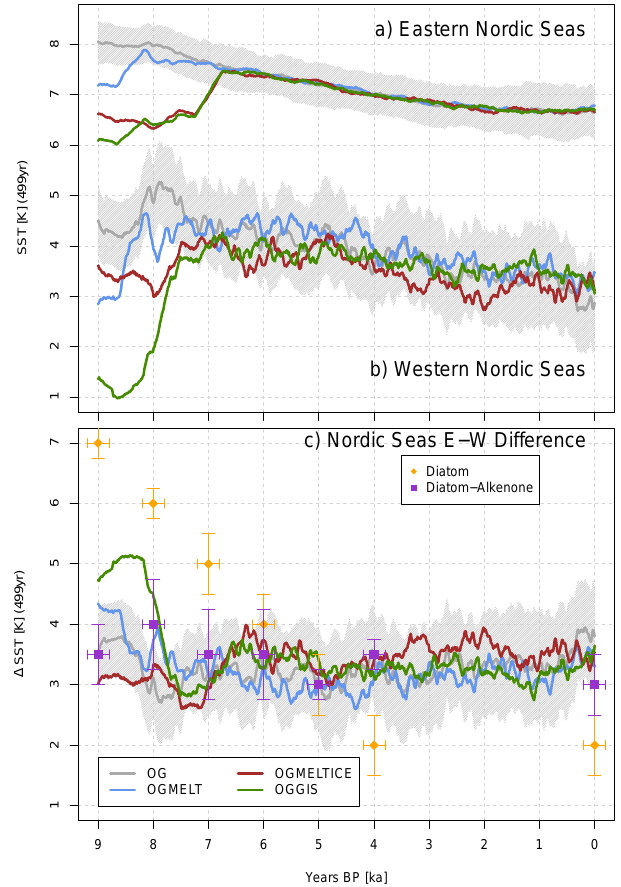
Fig. 6. Transient area weighted August SSTs for eastern and west- ern Nordic Seas and the difference from four transient simula- tions. (a) August SST in the eastern Nordic Seas (2.5–20 ◦ E, 66.25– 78.75 ◦ N) from 9 to 0kaBP. (b) August SST in the western Nordic Seas (47.5–10 ◦ W, 68.75–81.25 ◦ N) from 9 to 0kaBP. (c) Au- gust east–west SST difference across the Nordic Seas from 9 to 0kaBP. Grey represents OG; blue, OGMELT; red, OGMELTICE; and green, OGGIS. The grey area denotes the standard deviation of simulation OG. Orange dots represent approximate values from Andersen et al. (2004) for diatom-based SST gradient. The values shown in purple are constructed from Andersen et al. (2004) by combining the diatom-based SST estimate in the western Nordic Seas and the alkenone-based values (Calvo et al., 2002) in the east- ern Nordic Seas. Error bars denote approximate errors of mean val- ues in time (default 200 yrs) and